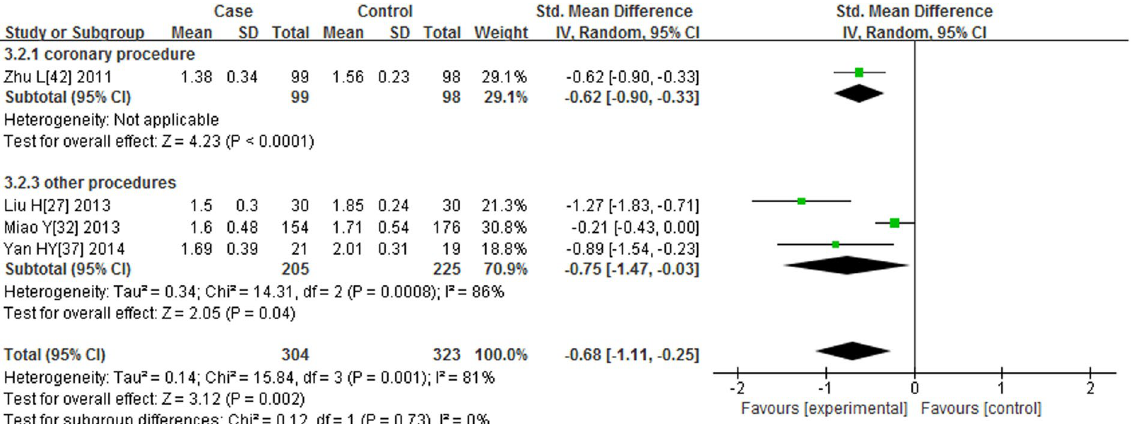
Figure 5. Forest plot of the association between using of alprostadil and the CysC level 48 hours after the contrast was administered, the horizontal lines correspond to the study-specific SMD and 95% CI, respectively. The area of the squares reflects the study-specific weight. The diamond represents the pooled results of SMD and 95% CI.